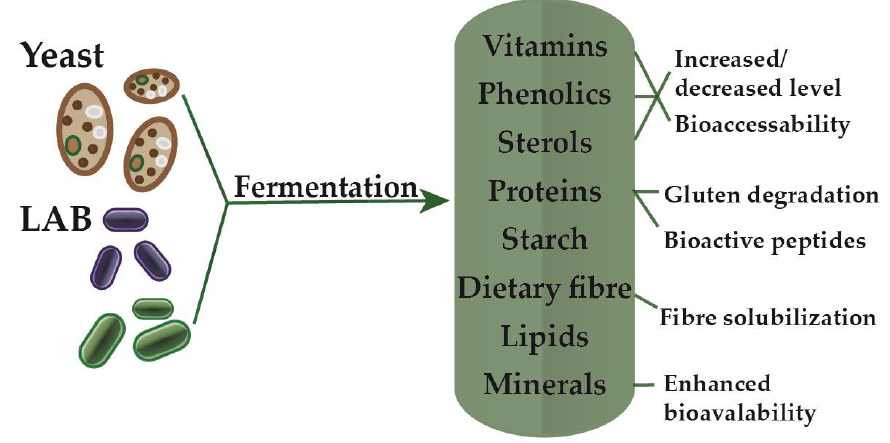
Figure 1. Nutritional influence of sourdough fermentation with yeast and lactic acid bacteria (LAB).